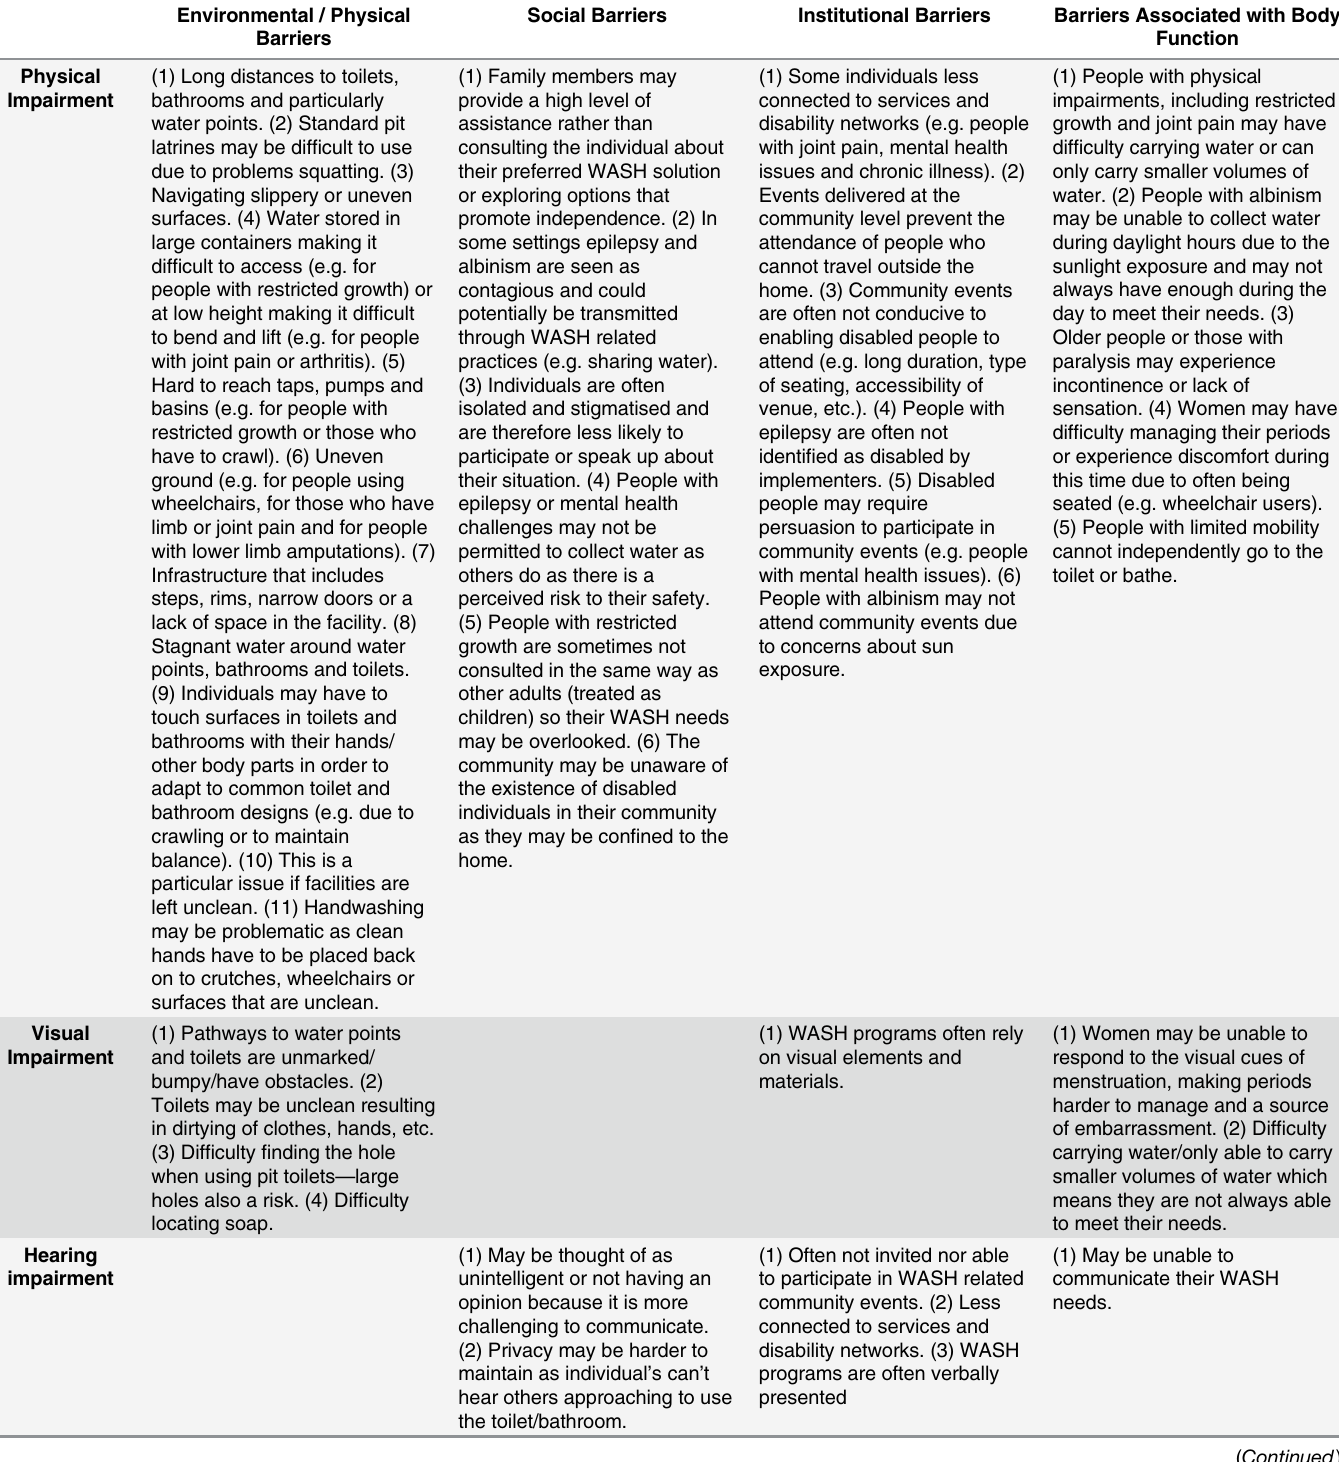
Table 6. Categorisation of reported and observed